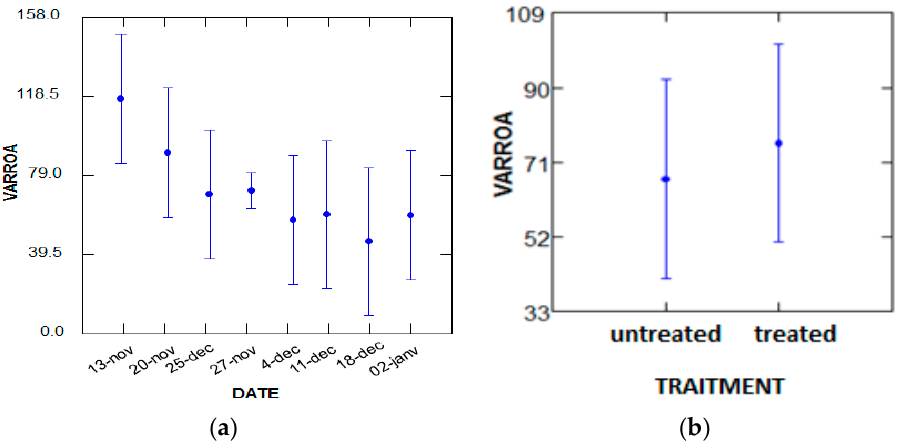
Figure 5. Analysis of the variance of the global number of dead varroa by factor period and treatment. ( a ) Date; ( b ) Traitment.